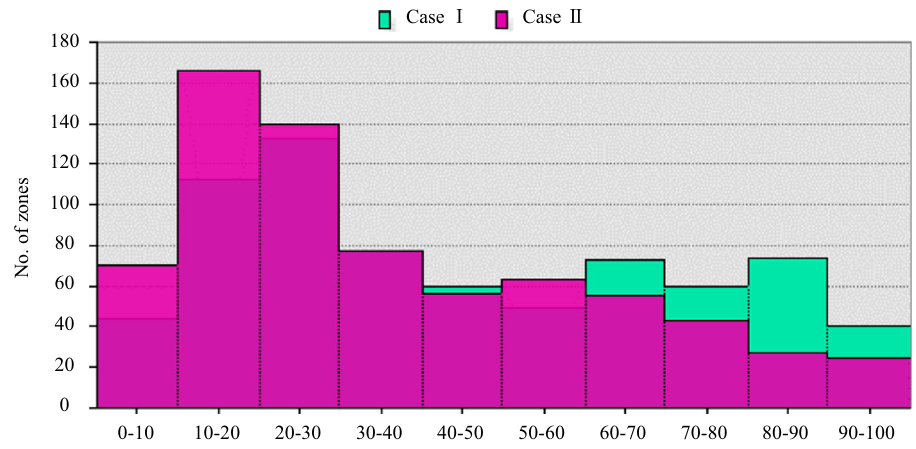
Fig. 7 Case II heat map